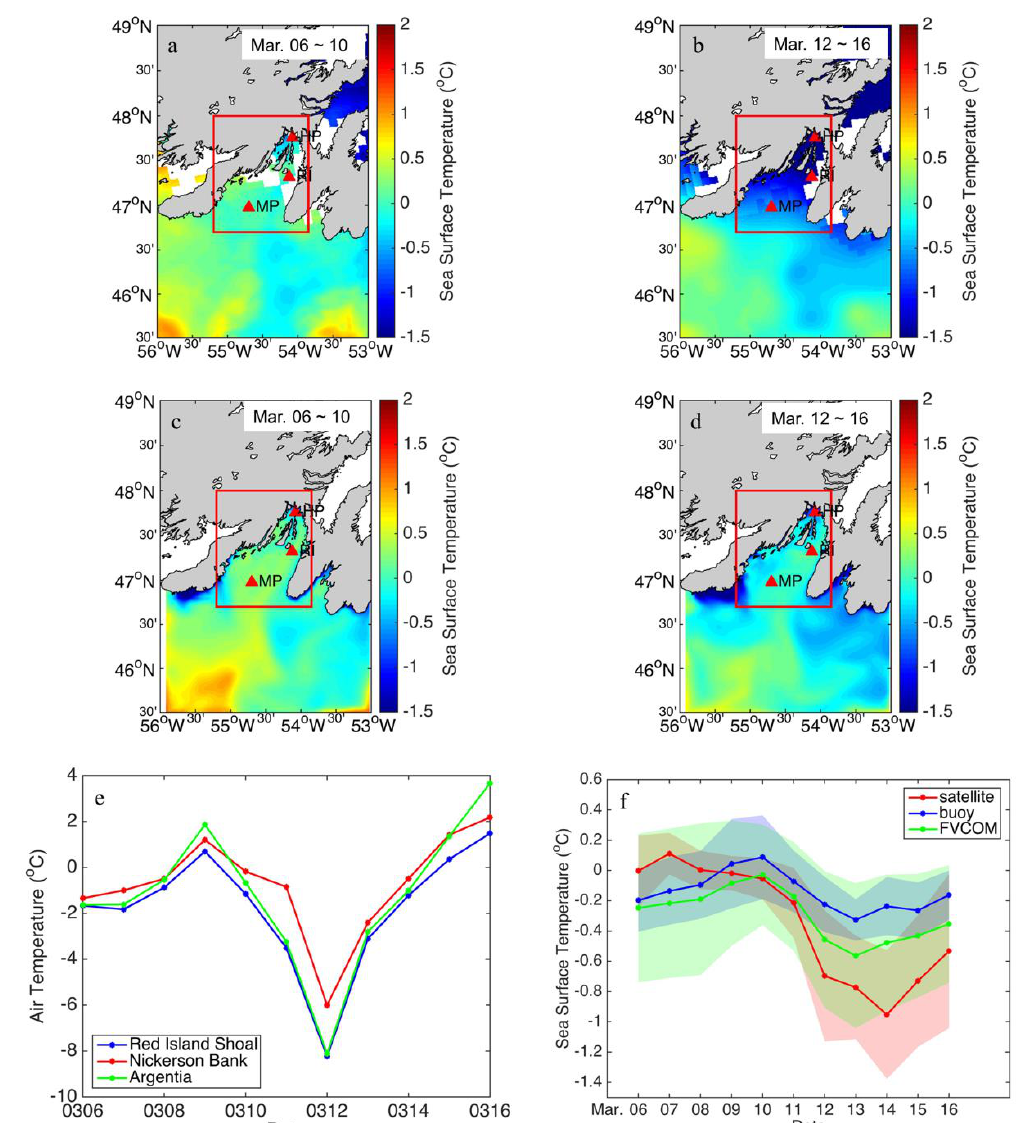
Figure 9. ( a , b ) Five-day averaged sea surface temperatures observed from satellites before (06–10 March) and after (11–16 March) the passage of the extratropical cyclone. The red squares denote the region in which the spatially averaged sea surface temperatures are calculated. ( c , d ) same as ( a , b ) except for the sea surface temperatures from FVCOM solutions. ( e ) Time series of daily averaged air temperature from buoys at RI and NB and from the weather station at AG. ( f ) Time series of daily spatially averaged sea surface temperature from satellite observations (red), buoy measurements (blue) and FVCOM solutions (green) with standard deviations shown as the shadows.